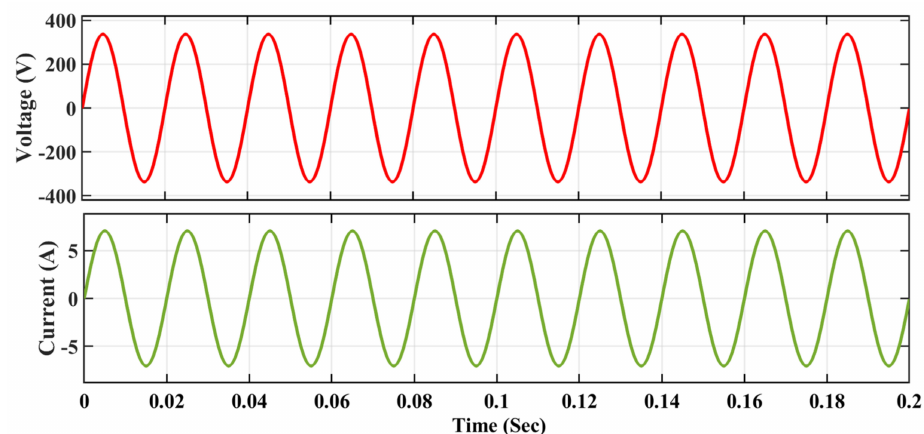
Figure 19. Grid voltage and grid current waveforms with PSOGA-PI controller.